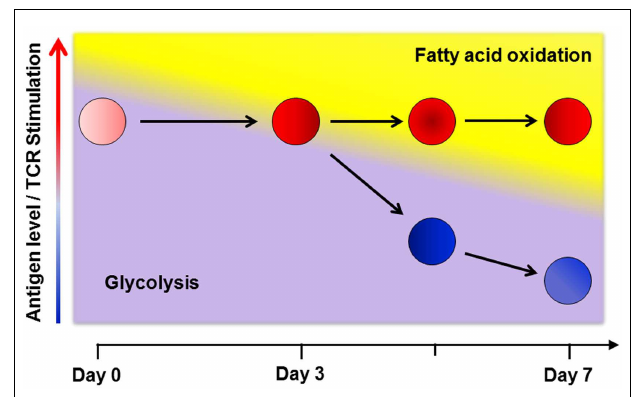
FIGURE 1 |A multi-step model of in vivo metabolic reprograming . Early in a graft-versus-host (GVH) response,T-cells use glycolysis, glutaminolysis and glucose oxidation to meet their short term energy needs (16, 21, 67). By day 3 post-transplant, robustly activated cells (shown in red) require additional metabolic reprograming to keep pace with ongoing energetic demands and so upregulate fatty acid oxidation (FAO) by increasing fat uptake, turning on co-activator molecules, and upregulating fatty acid oxidation enzymes.This transition comes with a concomitant rise in reactive oxygen species and a moderation in the rate of glycolysis (63, 68). In contrast,T-cells stimulated via cellular immunization, with a limited duration of antigen exposure, only transiently increase fat uptake and ROS on day 3. As antigen levels fall, stimulation decreases and cells no longer require FAO (cells shown in blue). Levels of oxidation enzymes, co-activator molecules, fat transport, and ROS levels decrease to baseline in these cells (63).Thus, despite similar CD44 Hi CD62L Lo effector profiles, the metabolic phenotype on day 7 is clearly different between robustly and transiently activatedT-cells. From these data, I propose that a primary determinant of metabolic reprograming in effectorT-cells is both the degree and